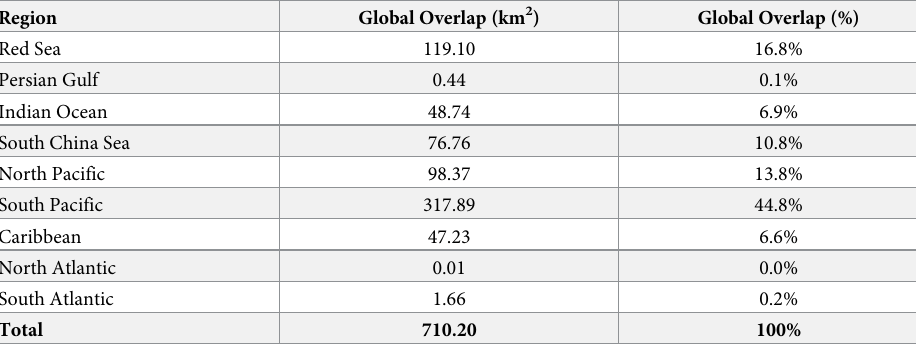
Table 4. Potential global extent of coexisting mangrove-coral habitats. Region